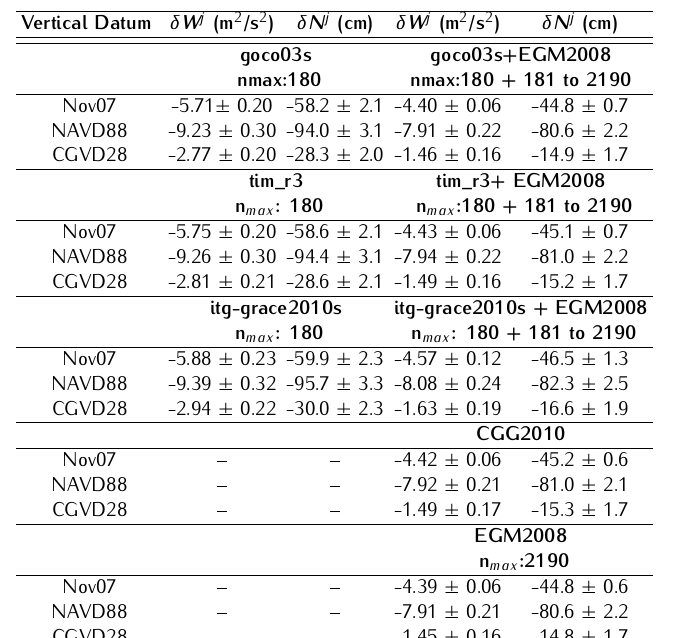
Table 2. Potential and vertical datum offsets for Nov07, NAVD88, and CGVD28 vertical datum evaluated with 308 GNSS/levelling benchmarks.